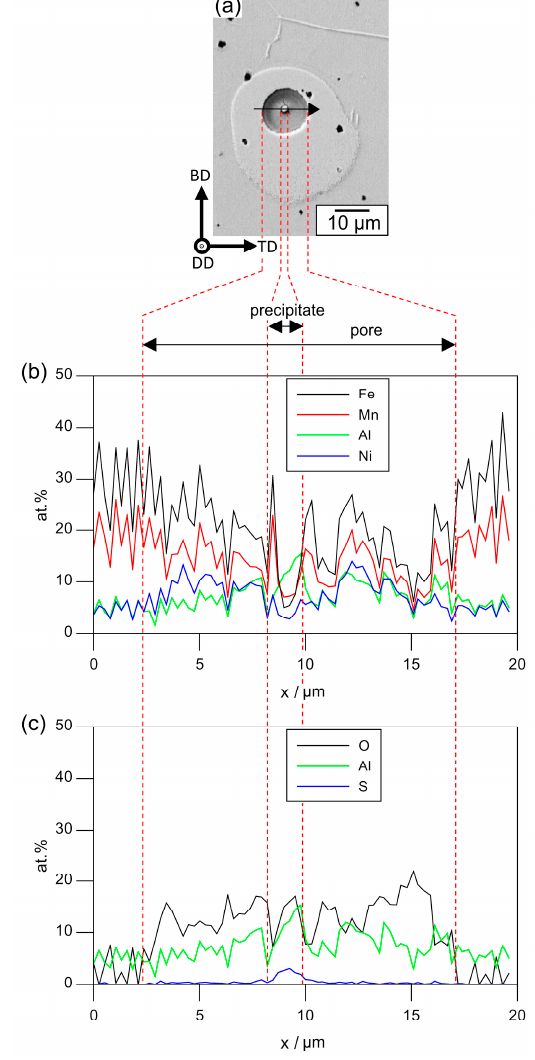
Figure 7. Analysis of a pore and precipitate using EDS line scans; ( a ) SEM image of the pore and precipitate (black arrow indicating the length and orientation of the EDS line scans); ( b , c ) showing the distribution of the main alloying elements Fe, Mn, Al and Ni and selected minor elements (i.e., O, S).